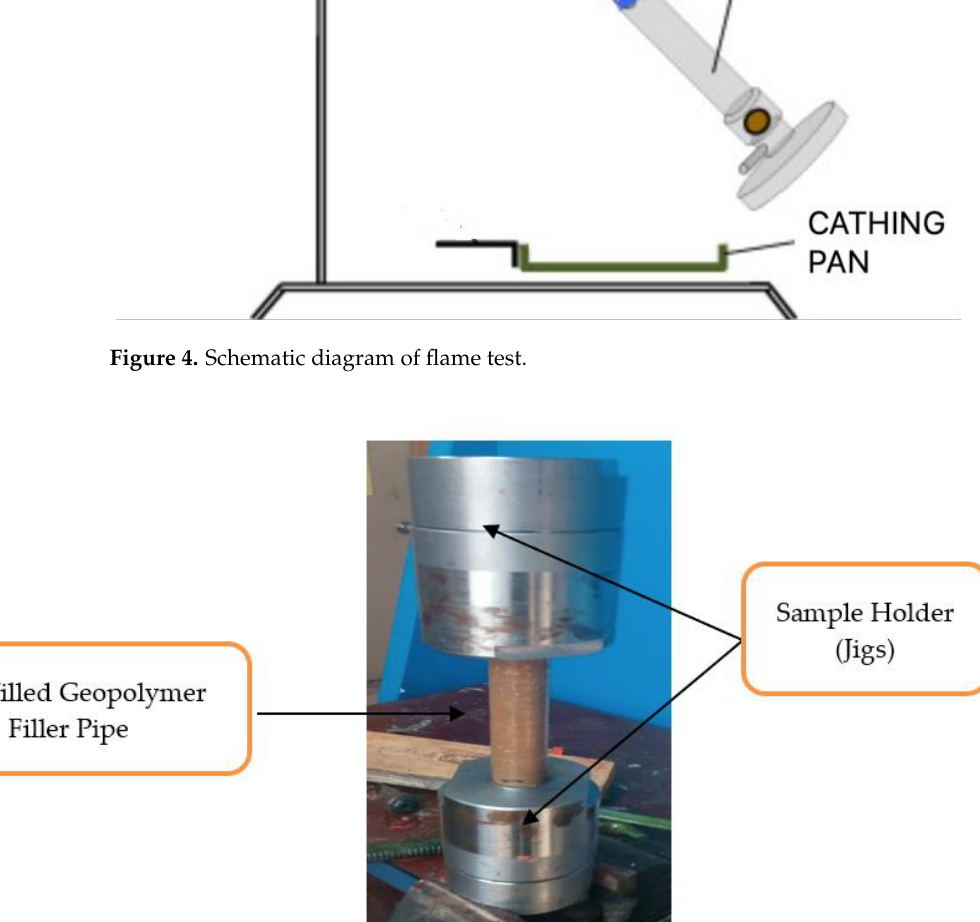
Figure 5. Hydrostatic pressure leak test.